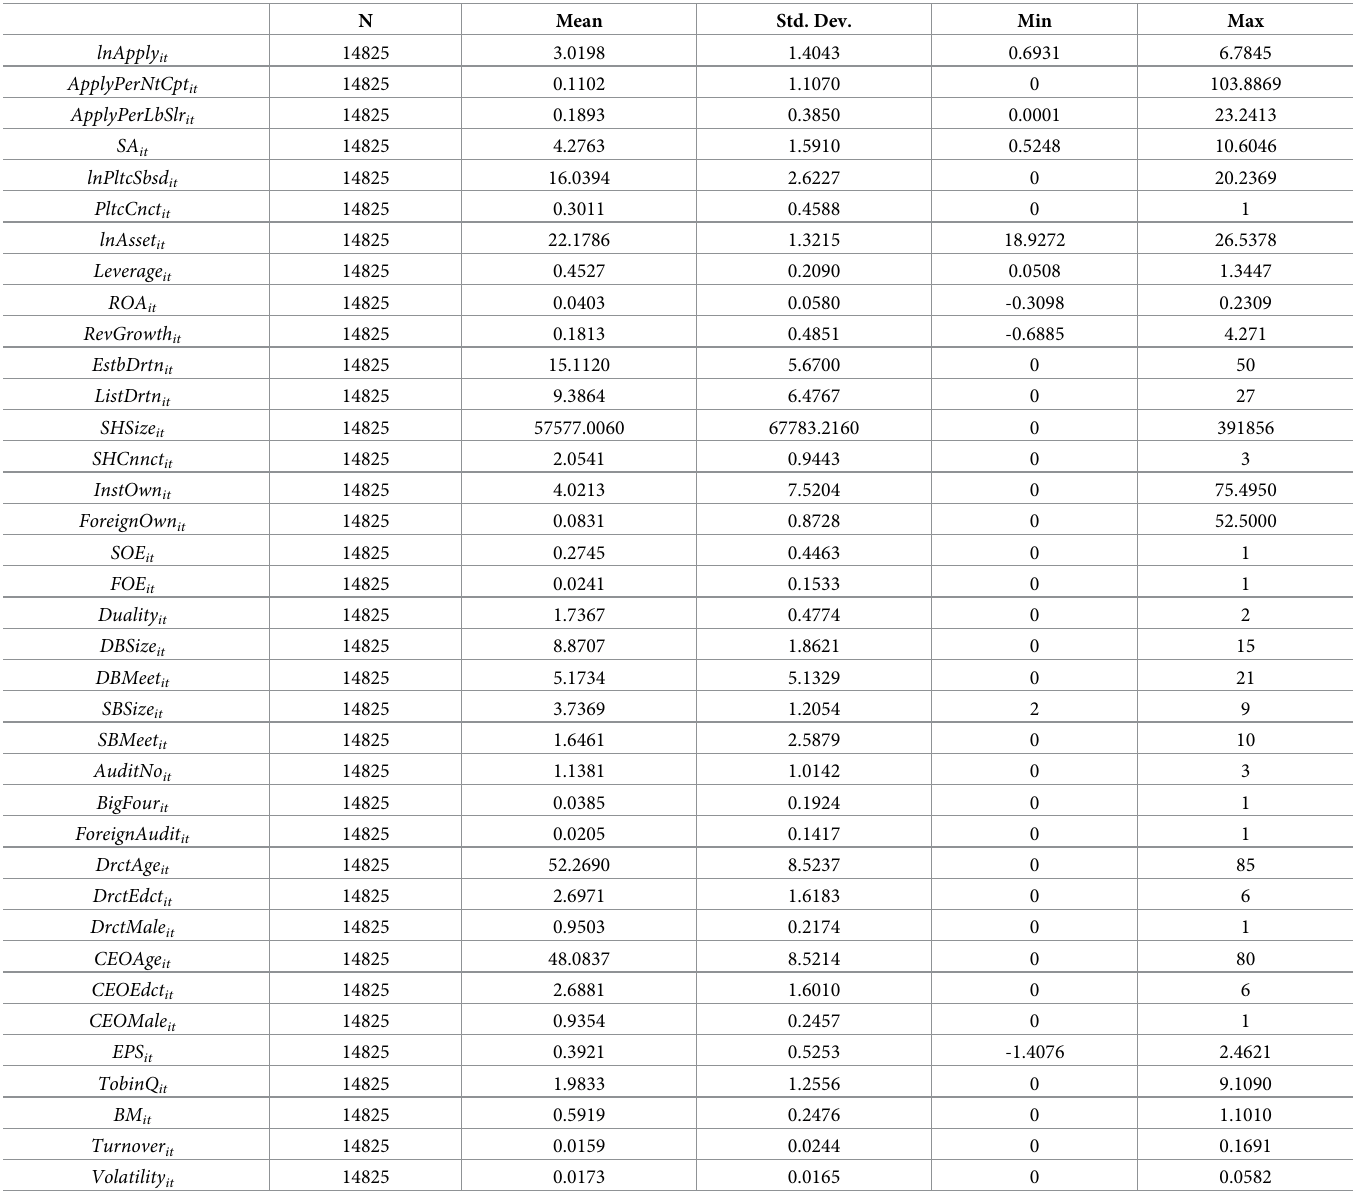
Table 1. Summary of